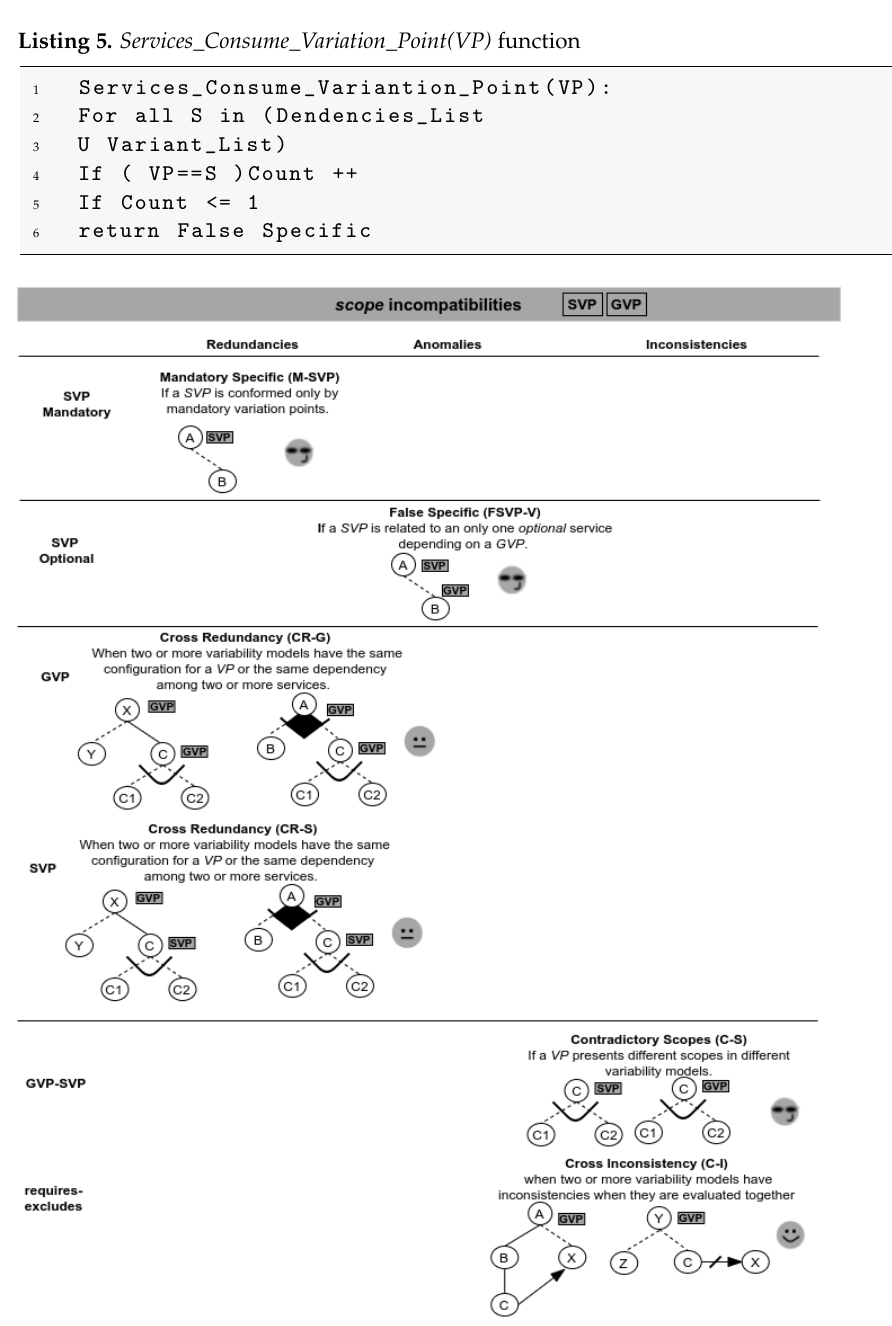
Figure 13. Validation scenarios involving scope